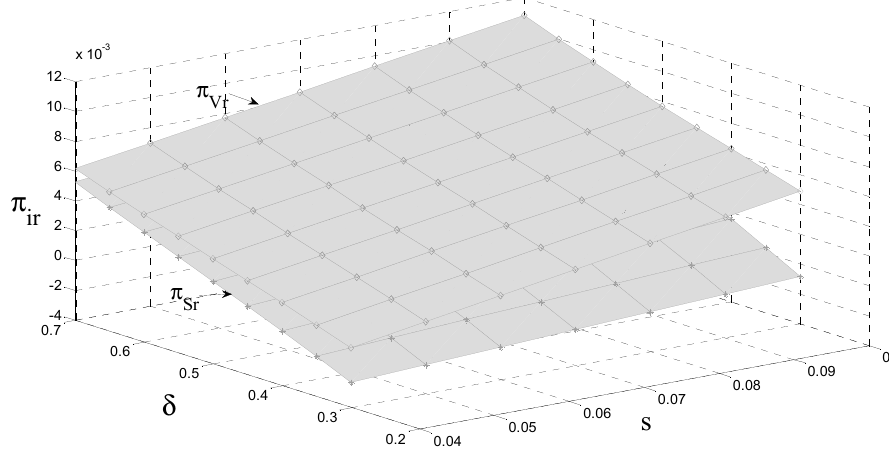
δ on the revenue of remanufacturers. Figure 6. The impact of s and δ on the revenue of